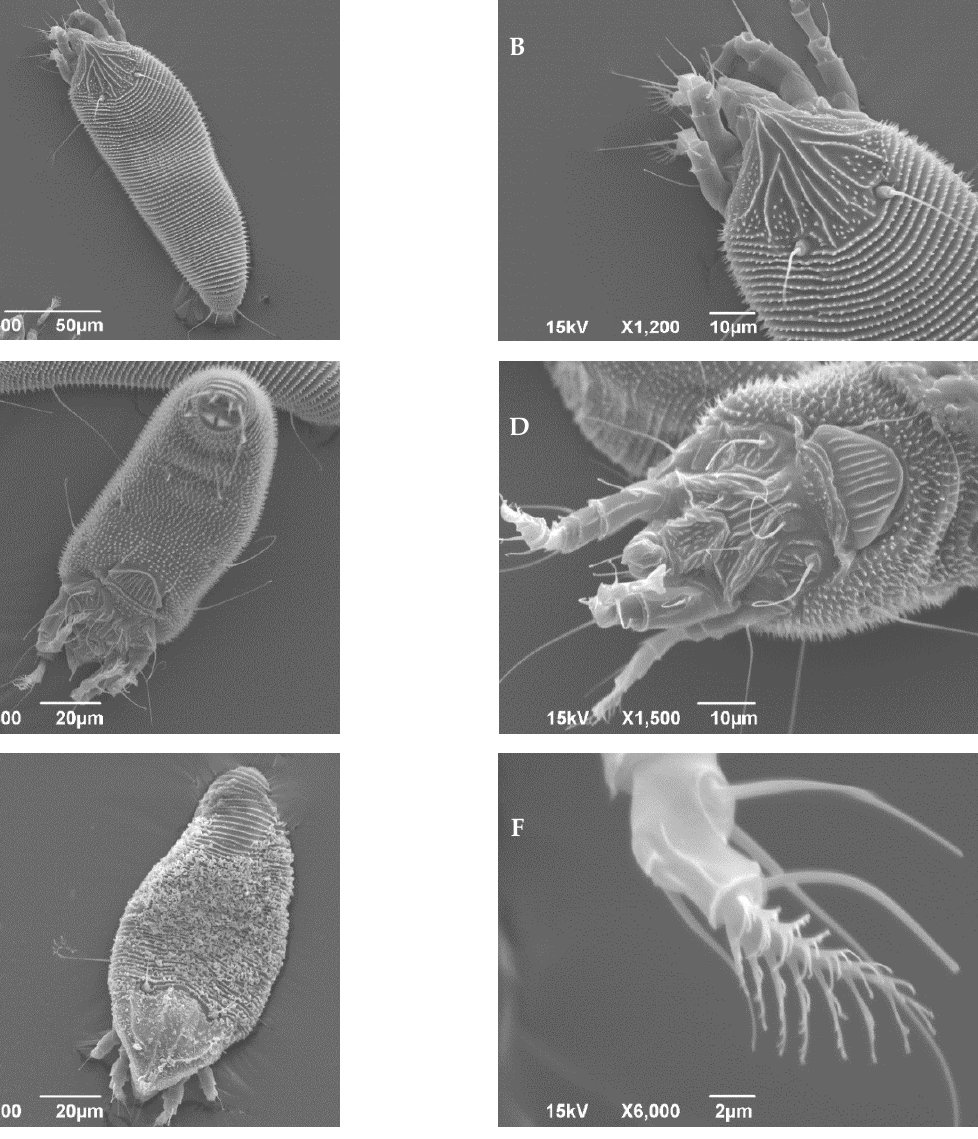
Figure 4. Scanning electron micrographs of Aculodes marcelli sp. nov. : ( A ) Dorsal view; ( B ) Dorsal view with detail of prodorsal shield; ( C ) Ventral view; ( D ) Ventral view, anterior half; ( E ) Dorsal view with apparent wax-like secretion; ( F ) Detail of tarsus.